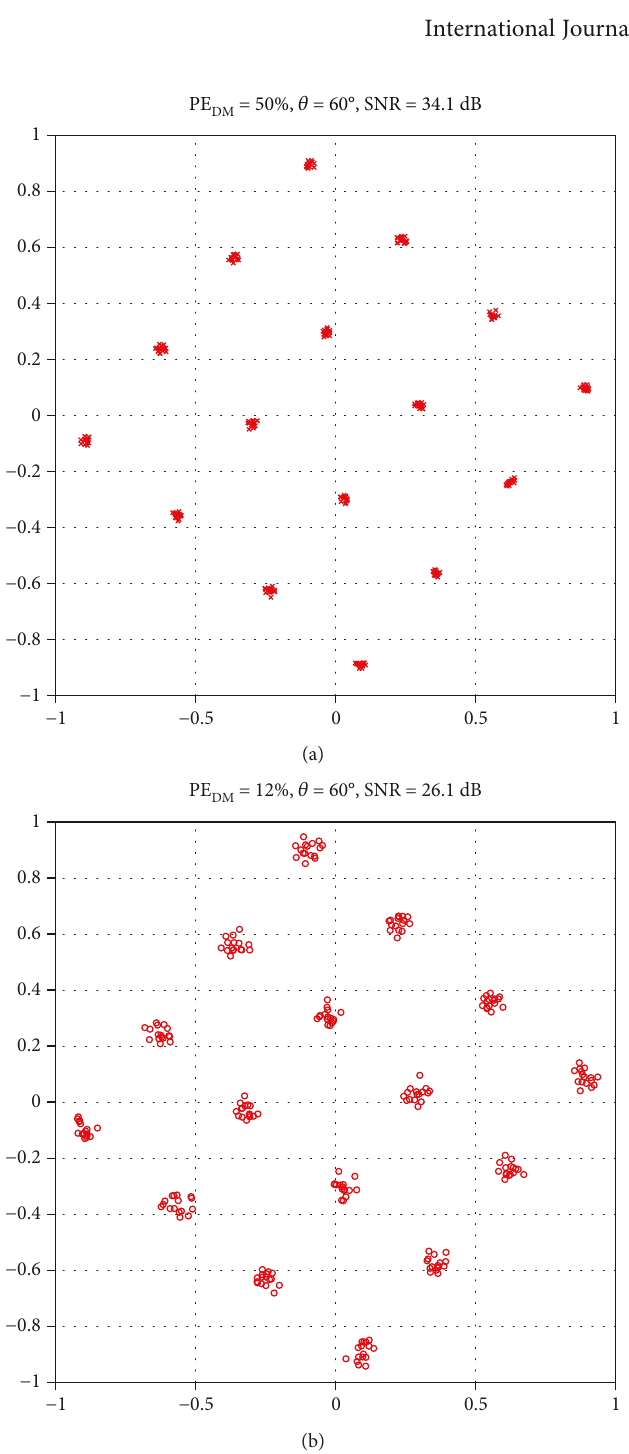
Figure 11: DDM 16-QAM modulation transmitted at the secure direction 60 ° using real components, coaxial cables and (11) to compute S 21 mn in the vector modulators; AEP measurement did not consider coaxial cables. (a)